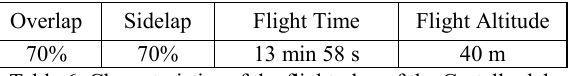
Table 6. Characteristics of the flight plan of the Castello del Valentino’s dataset.